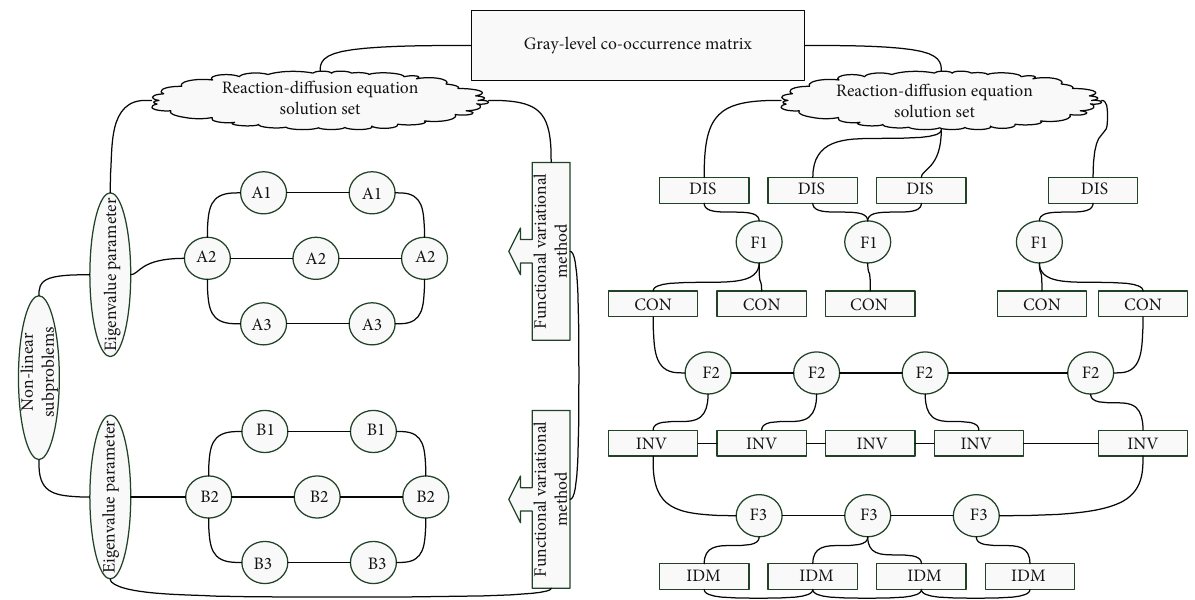
Figure 1: The spatial distribution of the solution set of the reaction-di ff usion